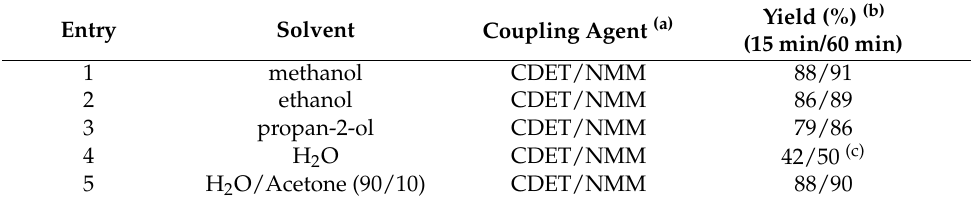
Table 1. Condensation reaction of I and II in the presence of CDET/NMM in different solvents. Entry